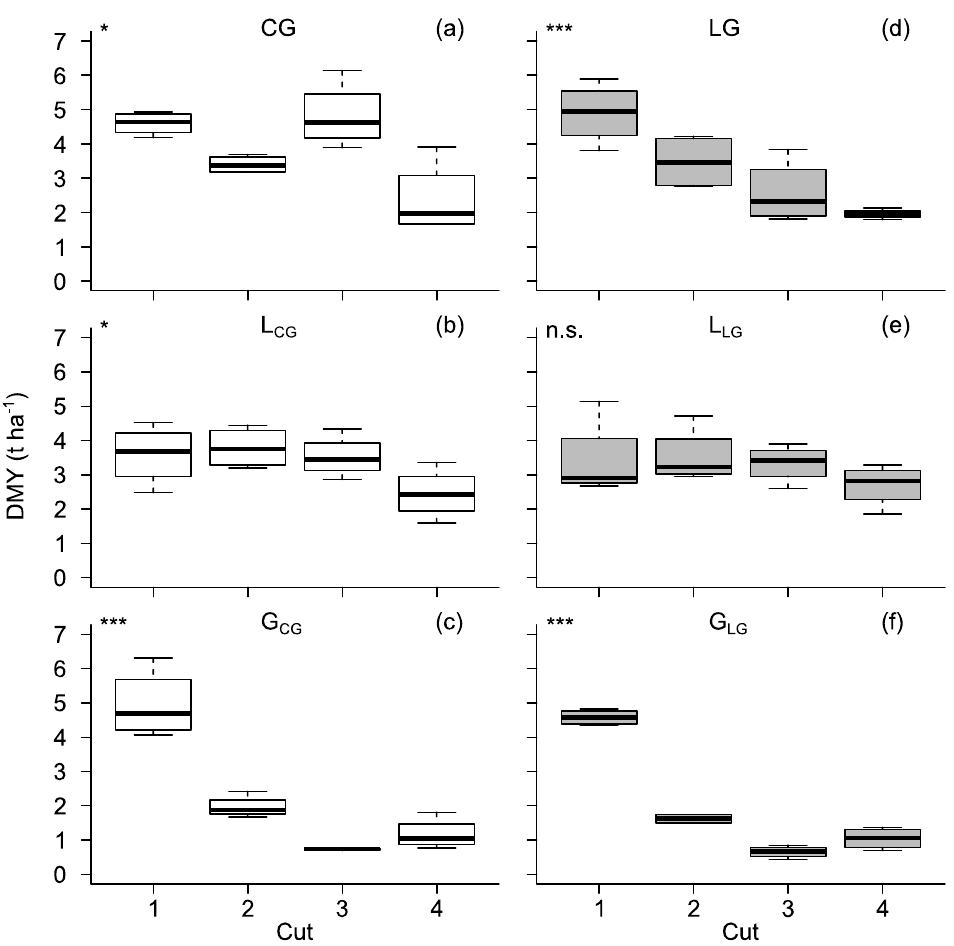
Figure 3. Dry matter yield (DMY) at four cuts of clover-grass (CG, left) and lucerne-grass (LG, right) mixtures ( a , d ) as well as pure stands of legumes (L) (b, e ) and grasses (G) ( c , f ). *** = p < 0.001; * = p < 0.05; n.s. = not significant.